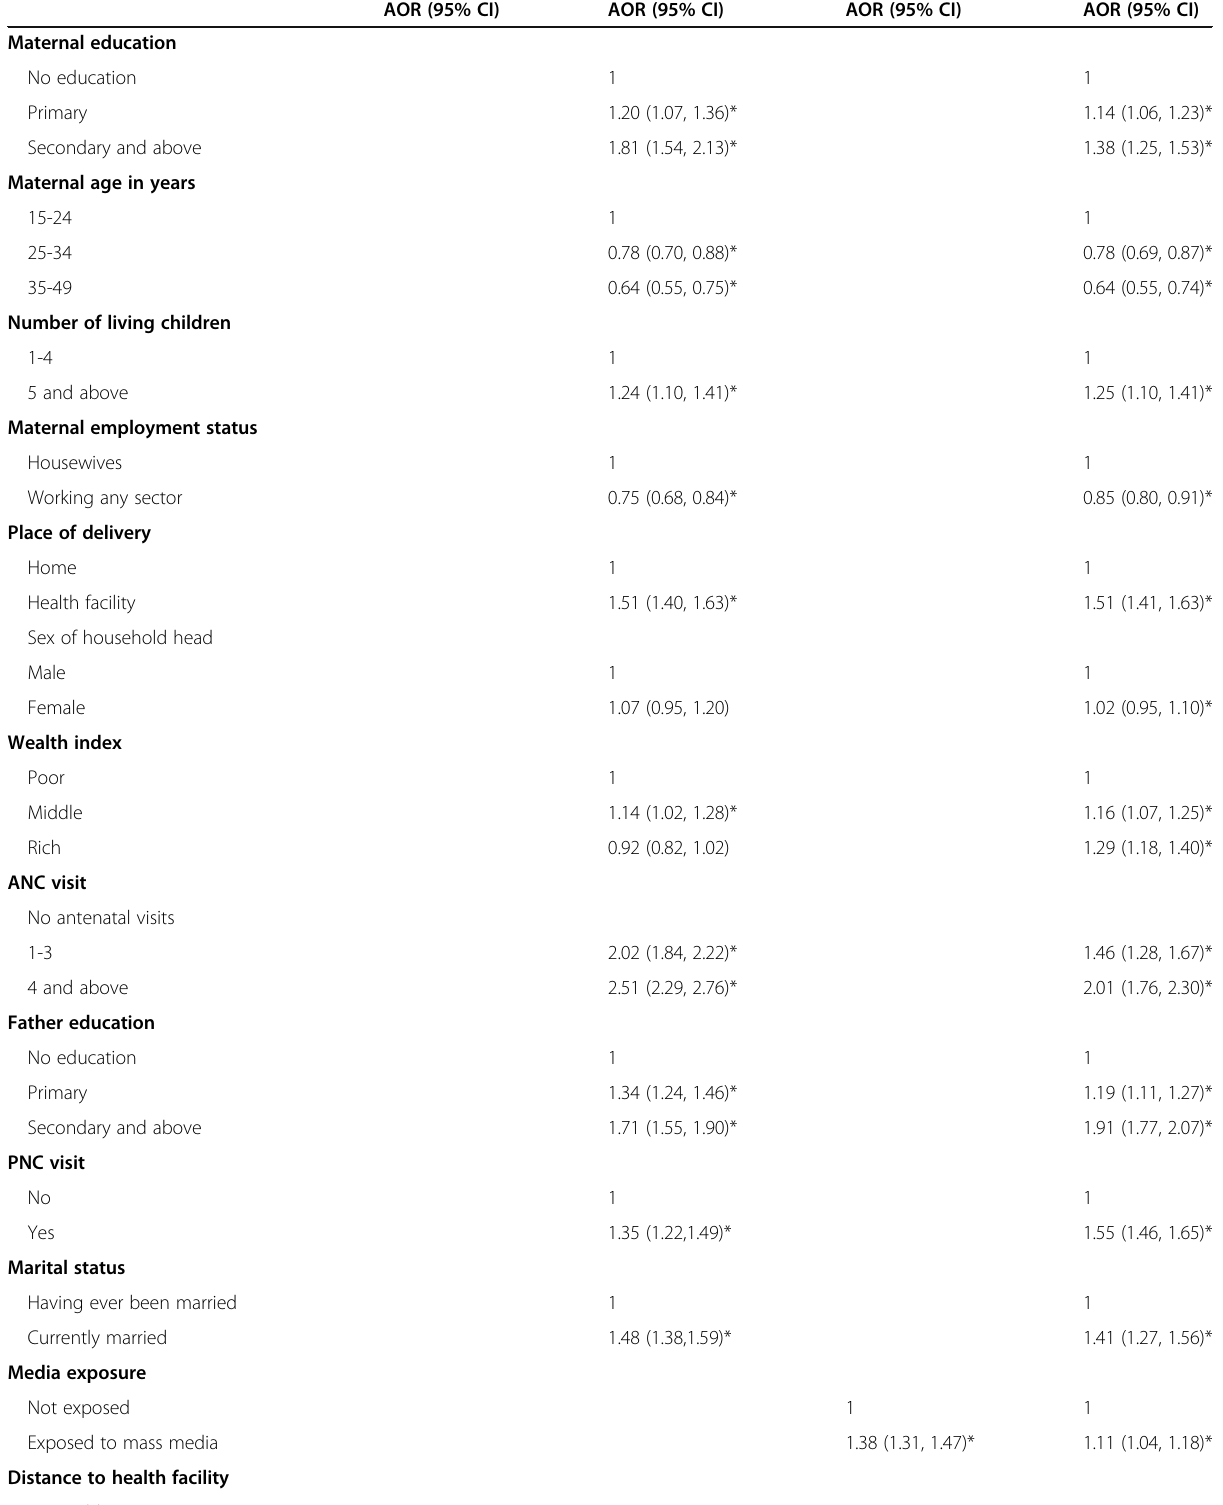
Table 3 Multivariable multilevel logistic regression analysis of both individual and community-level factors associated with childhood immunization in sub-Saharan African